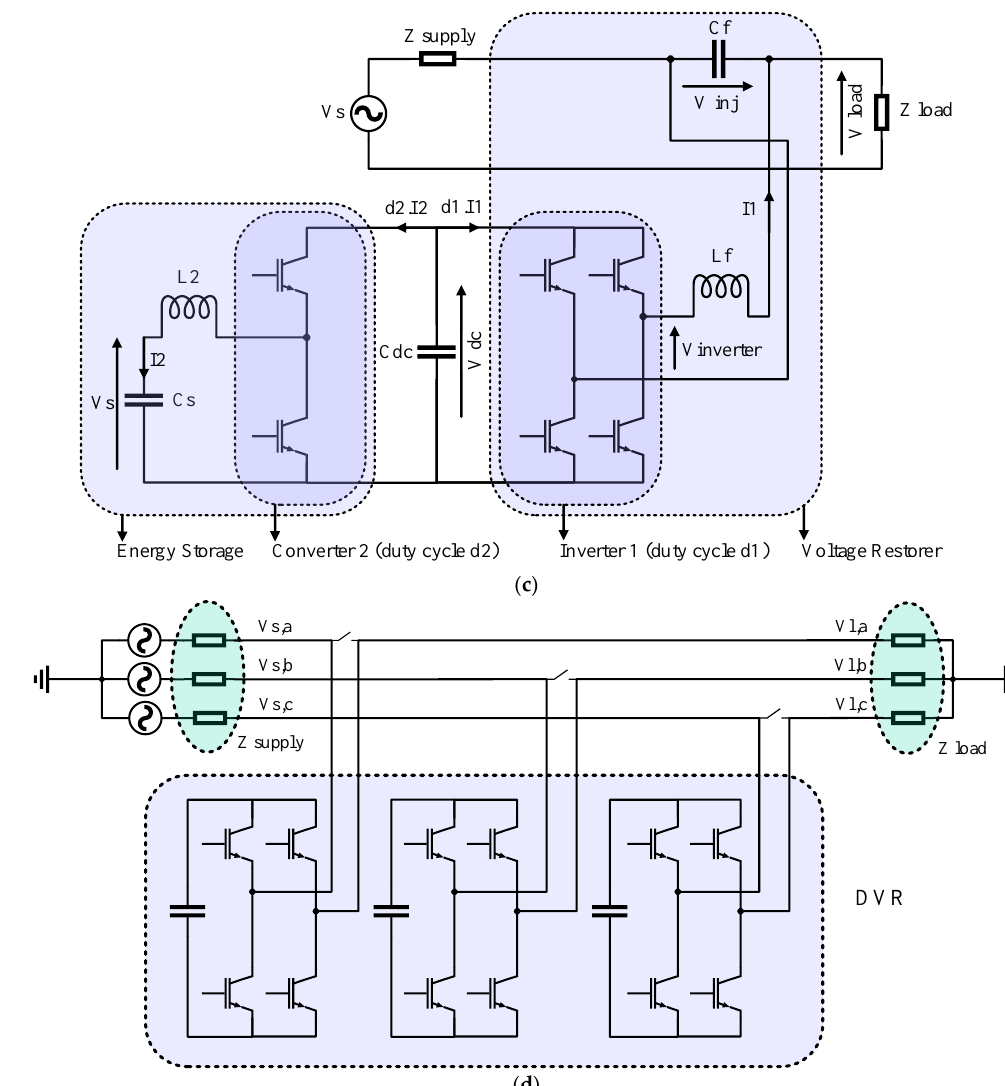
Figure 13. Modified DVR configurations: ( a ) Fault Current Limiter/Controller DVR (FCC DVR), ( b ) Interline DVR (IDVR) with two independent feeders, ( c ) Transformer-less DVR (TDVR), and ( d ) Transformer-less DVR (TDVR) with three full-bridge inverters. Based on data from [73,76,78,113,144,171–183]. Distributed Generation Integration with